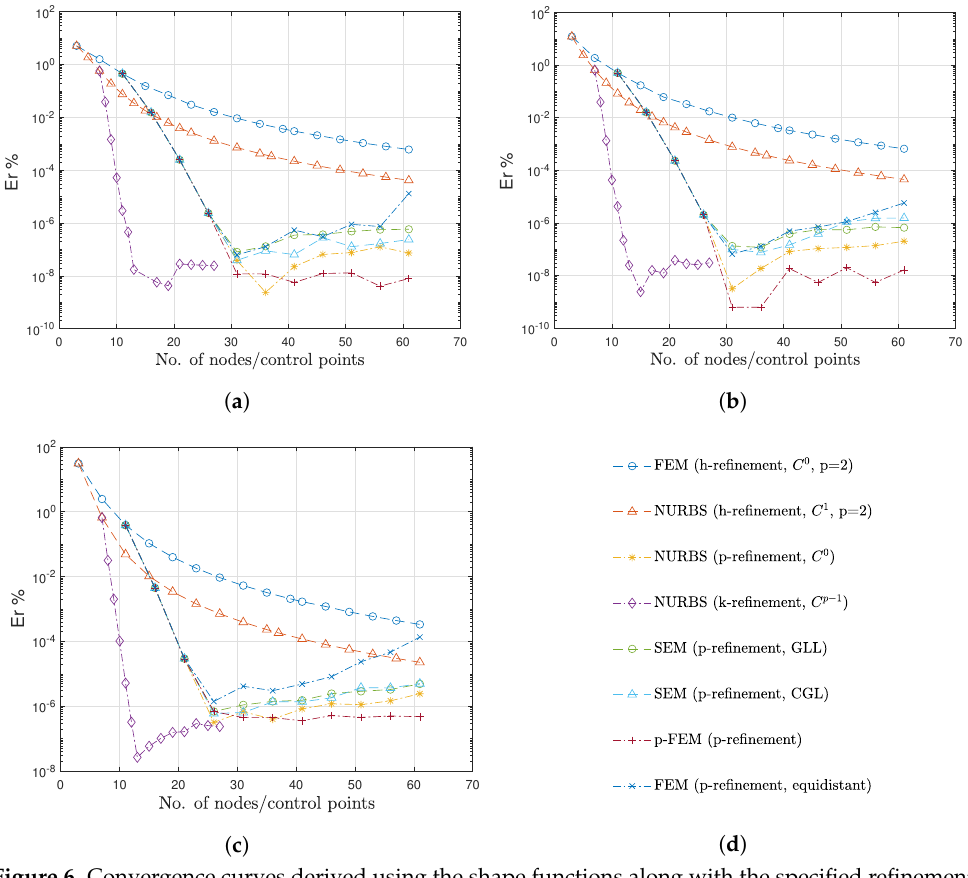
Figure 6. Convergence curves derived using the shape functions along with the specified refinement technique in aluminum plate problem, ( a ) 1st mode, ( b ) 2nd mode, ( c ) 3rd mode, ( d )